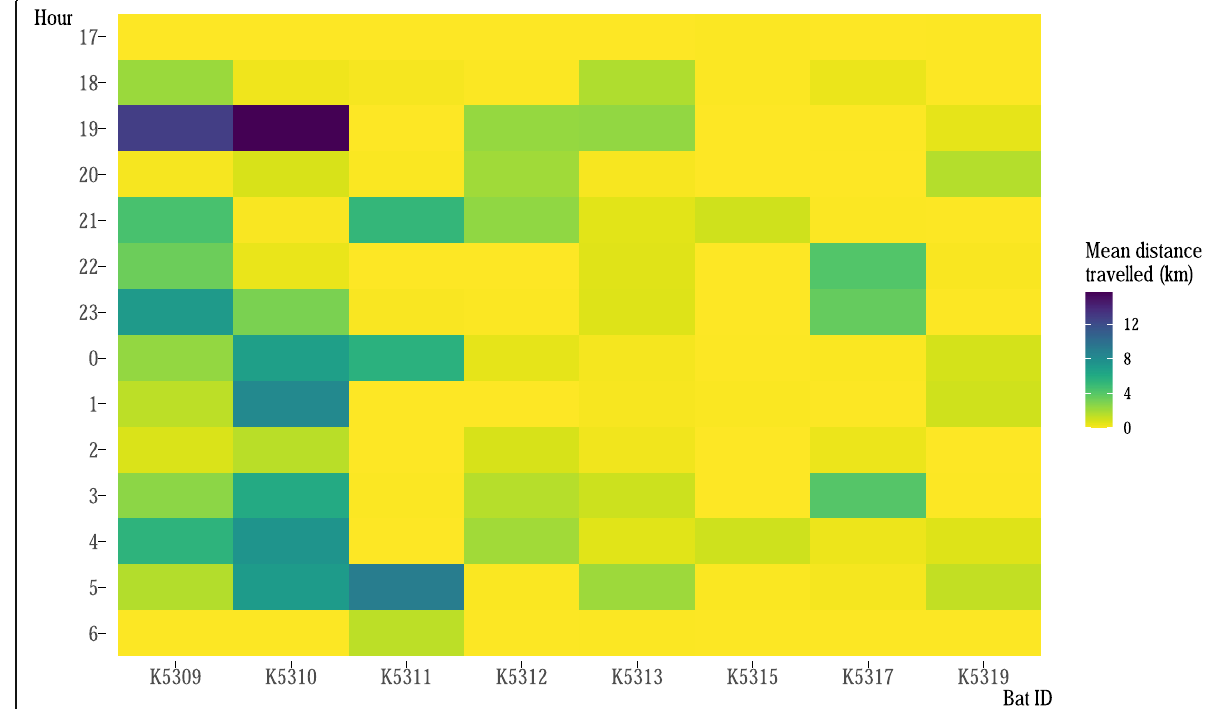
mean hourly distances flown by all bats is shown in Fig. 5 and presented in Additional file 5: Table S5.2. Home range sizes varied between 51.49 and 124,413.78 ha based on 95% KDE (Table 1 and Additional file 6: Figure S6). The bats tended to visit the same sites on subsequent nights (Additional file 7: Figure S7), and while all male e-obs tagged bats flew in a direction south of their roosting col- ony, the only female e-obs tagged bat (K5317) flew in the northern direction (Fig. 2).